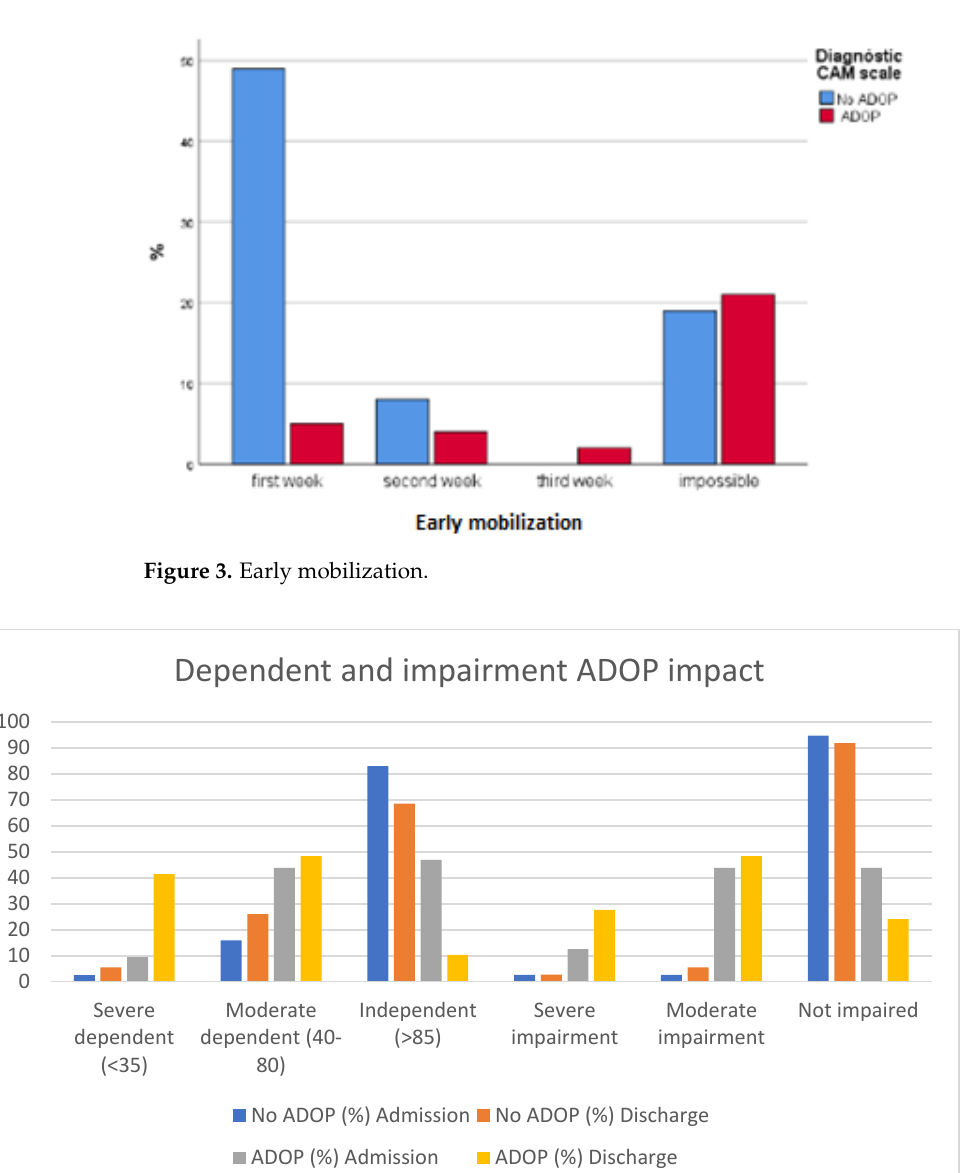
Figure 4. Dependent and impairment ADOP impact.